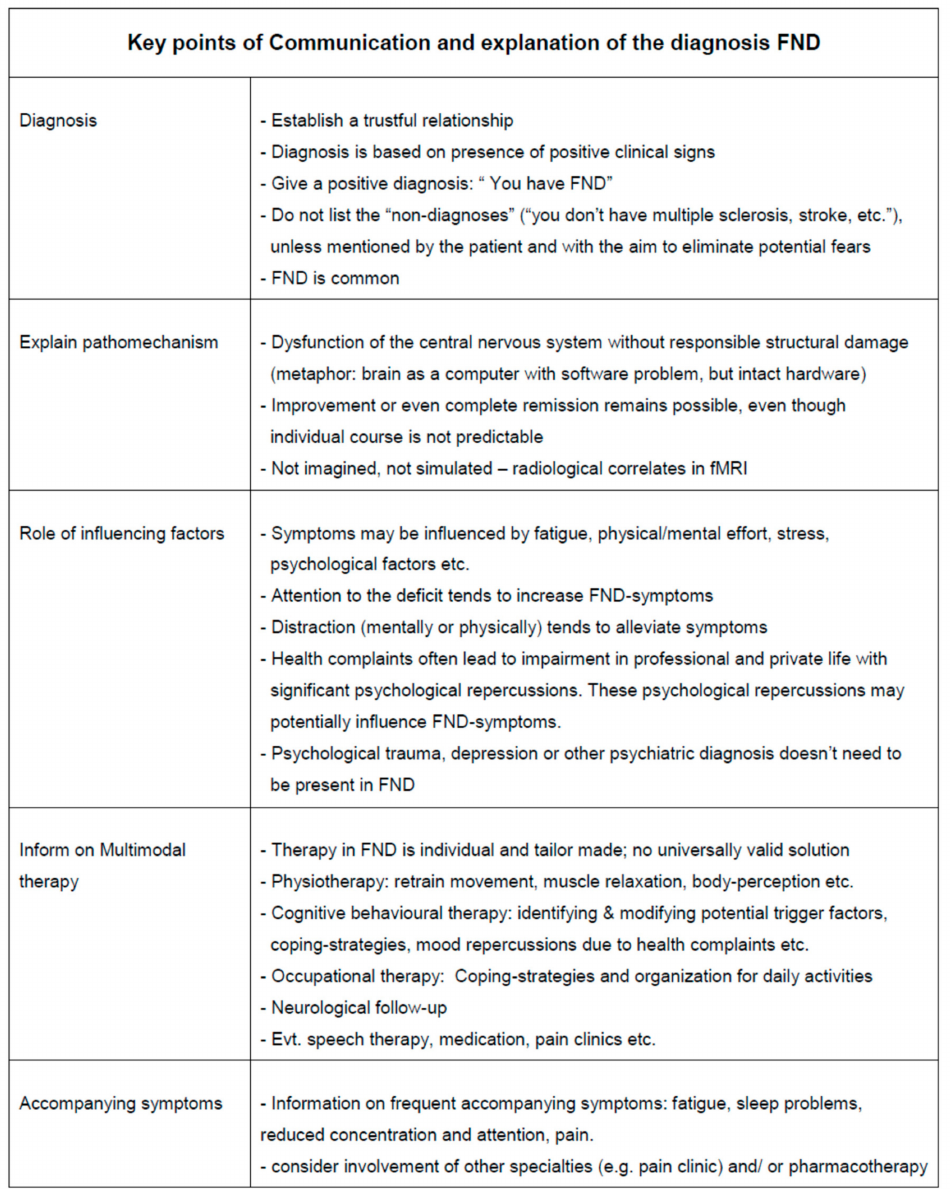
Figure 3. Key points of communication and explanation of the diagnosis of